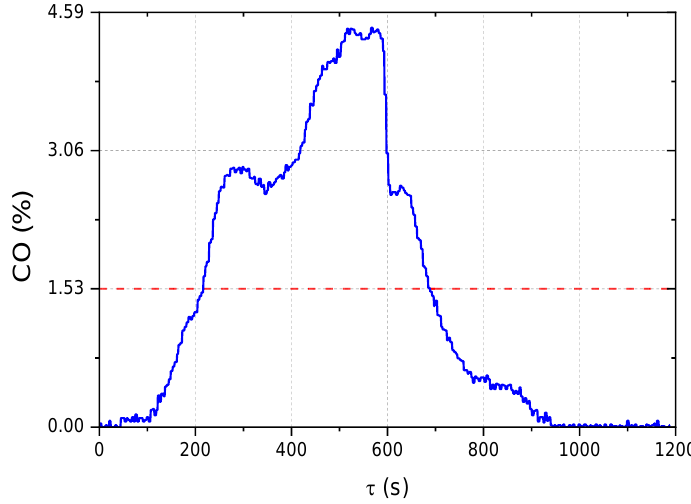
Figure 2. CO emission trend during microwave pyrolysis of